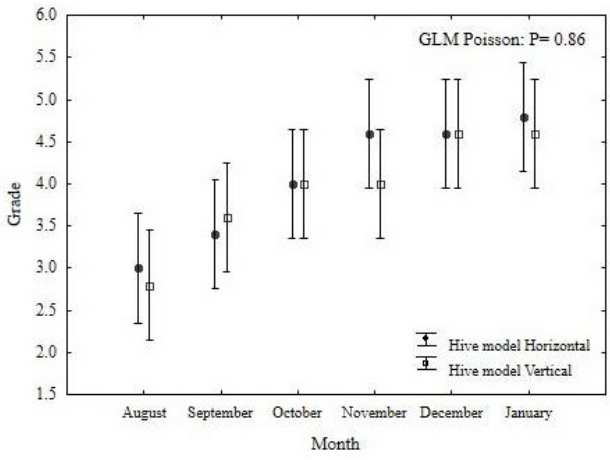
Fig 3 . Variation of the subjective grades (1-very poor; 2-poor; 3-average; 4-strong; 5-very strong) of 10 Scaptotrigona aff. postica colonies housed in horizontal and vertical hives. Data presented as median and SE.